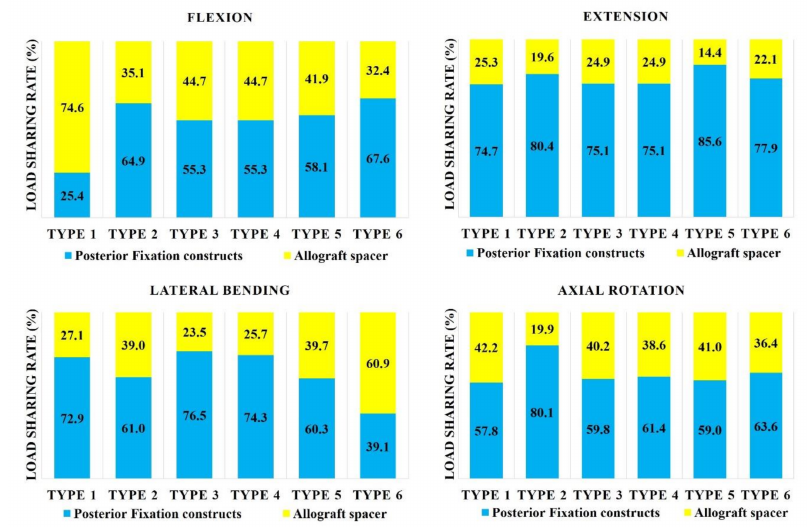
Figure 2. Load sharing on allograft spacers and posterior fixation constructs. Type 1: all LMS, Type 2: all PS, Type 3: left (Lt) PS and right (Rt) LMS, Type 4: Lt LMS and Rt PS, Type 5: upper PS and lower LMS, and Type 6: upper LMS and lower PS.